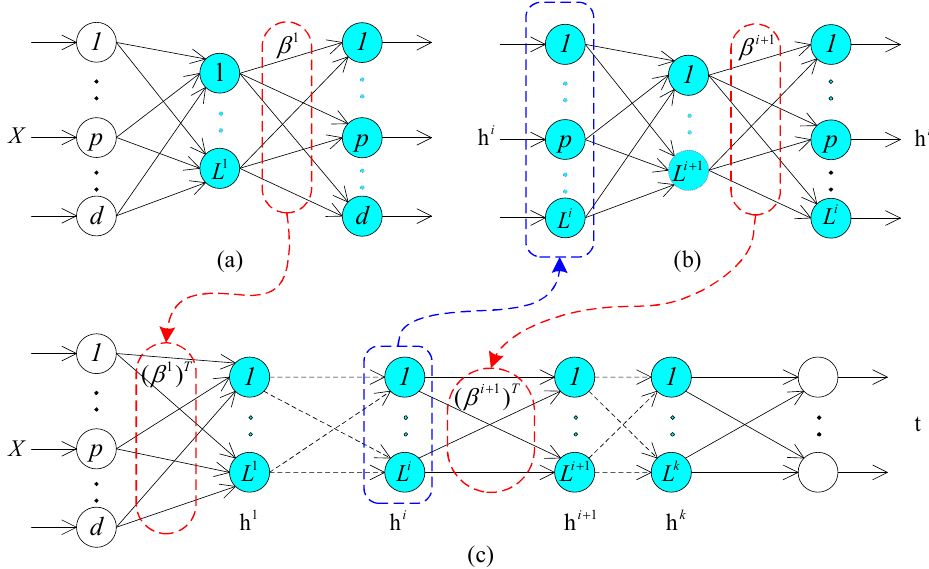
Figure 2. The proposed fault diagnostic framework using an extreme learning machine (ELM) based autoencoder and classifier. ( a ) ELM-autoencoder (AE) output weights β 1 with respect to input data x are the 1st layer weights of Multilayered (ML)-ELM; ( b ) The output weights β i + 1 of ELM-AE, with respect to ith hidden layer output hi of ML-ELM are the i + 1 th layer weights of Multilayered-ELM; ( c ) The Multilayered-ELM output layer weights are calculated using regularized least